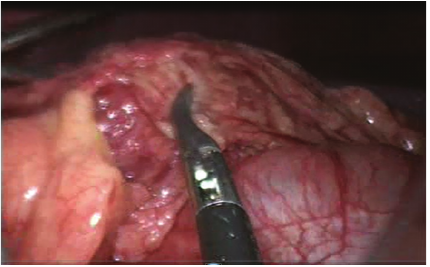
Figure 1: CT scan showing increased fat density mass in the upper quadrant.